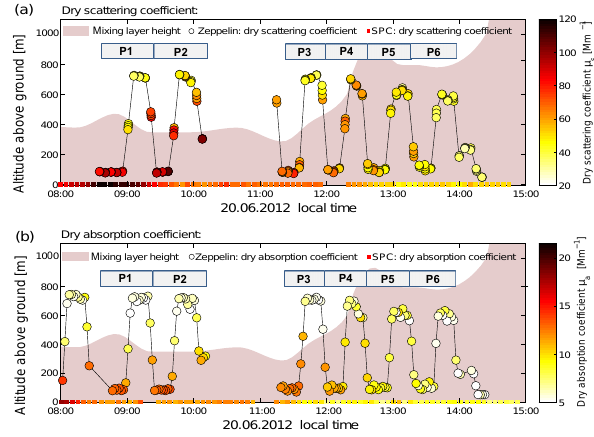
Figure 4. Time evolution of the dry scattering (a) and absorption (b) coefficients from the airborne and ground-based platforms. The colour scale represents the magnitude of the coefficients. The un- certainty of the dry scattering coefficients is estimated to be ± 18%, while ± 20% is estimated for the absorption coefficients. Addition- ally, the shading in (a) and (b) denotes the estimated mixing layer height (compare to the violet line in Fig. 2) and each height profile ( P 1– P 6) is